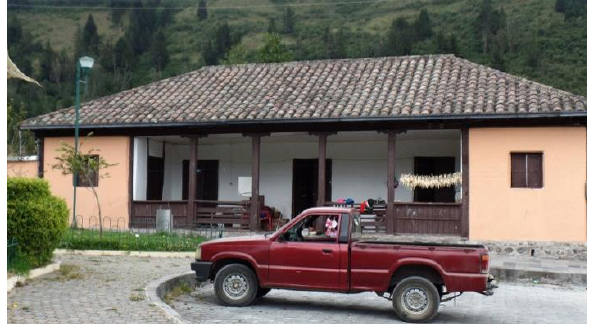
Figure 3. Porch type house, Nono, Ecuador, 2019.